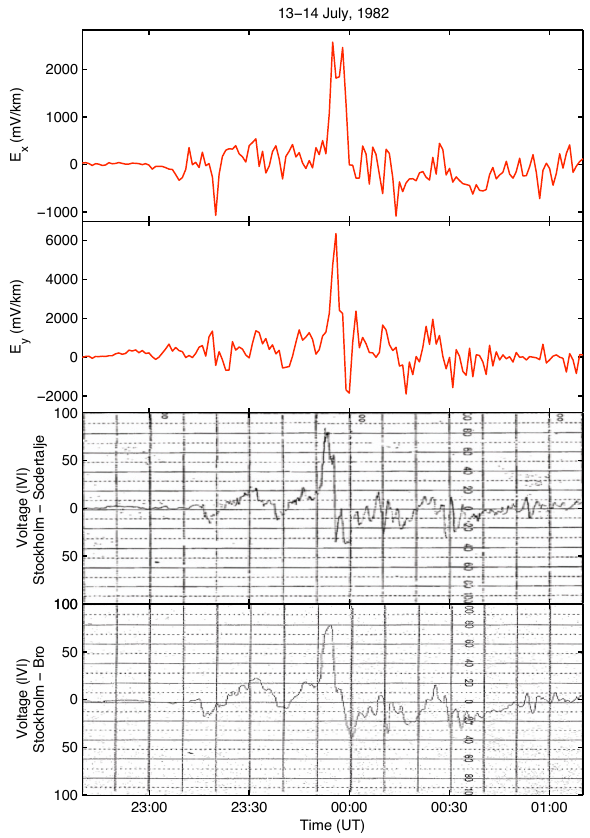
Fig. 5. Two voltage recordings (lower panels), together with elec- tric field calculations (upper panels), from 22:40UT on 13 July to 01:10UT on 14 July 1982. The first recording is from an ap- proximately southwest-directed telecommunication cable of about 28.7km between Stockholm and S¨odert¨alje. The second recording is from an approximately northwest-directed telecommunication ca- ble of about 28.0km between Stockholm and Bro. The calculated electric field data refer to the more northern red grid point in Fig.